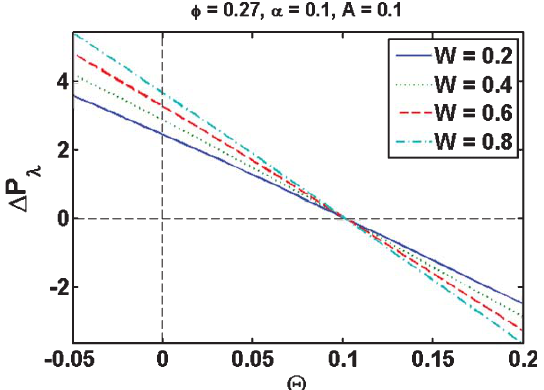
Fig. 16. Variation in (cid:12)P λ against (cid:10) for different values of fluid parameter ( W ).